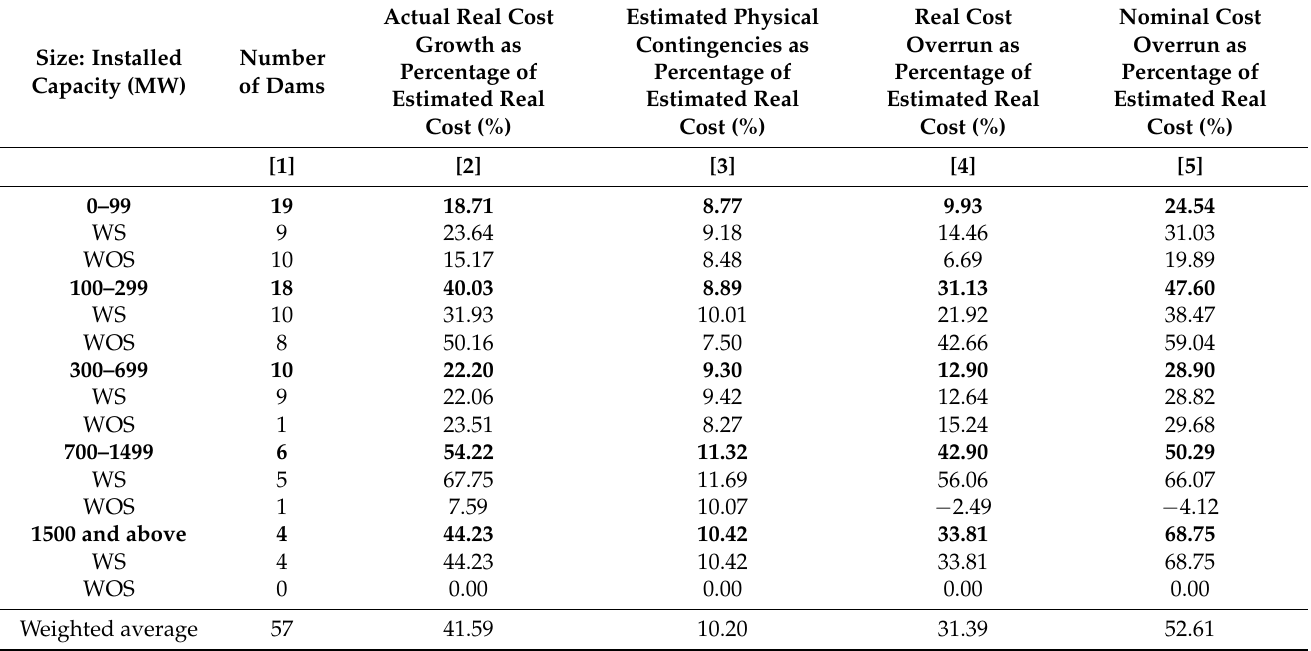
Table 5. Incidence of cost overrun by size of installed